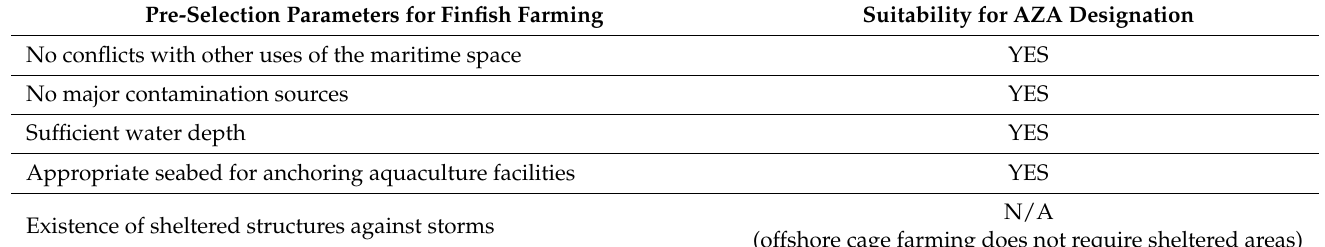
Table 1. Pre-selection criteria of the proposed AZA for finfish farming (Mangalia) (adapted from [17]).